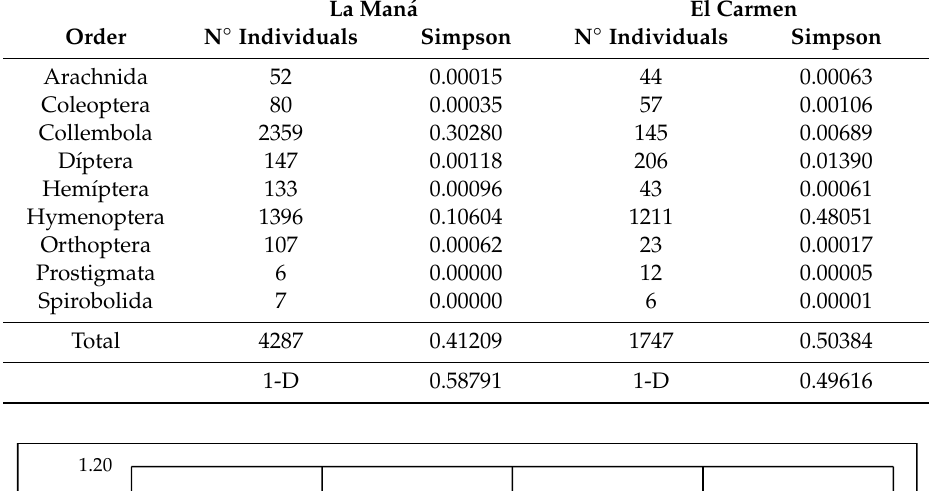
0.000.200.400.60